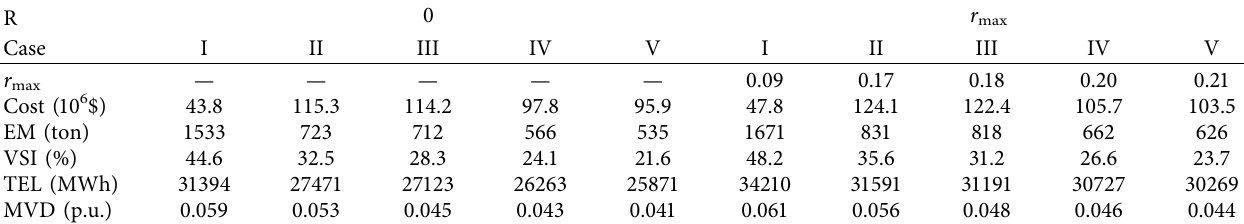
Table 5: Values of technical and economic indices for different uncertainty levels in Δϑ �